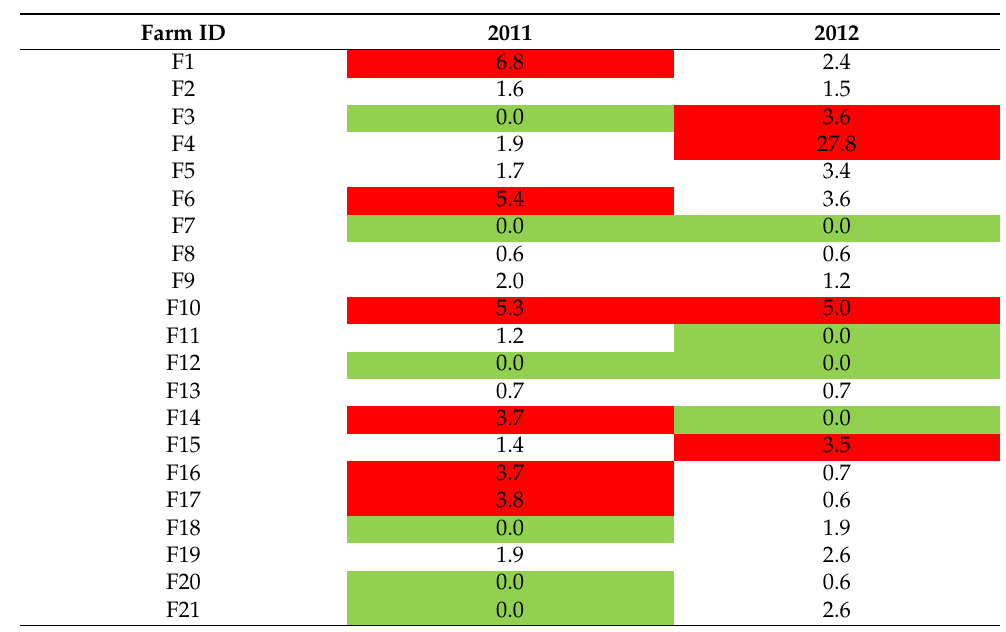
Table 5. Frequency of infection by black point in wheat grain samples from the 21 Tajik farms surveyed in two study years.